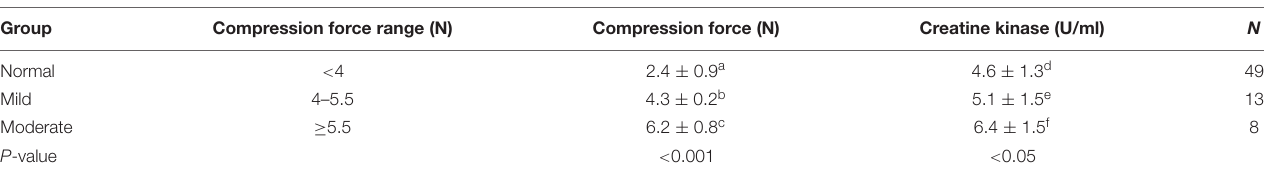
TABLE 5 | Serum CK level of different group at 42 days of age in flock